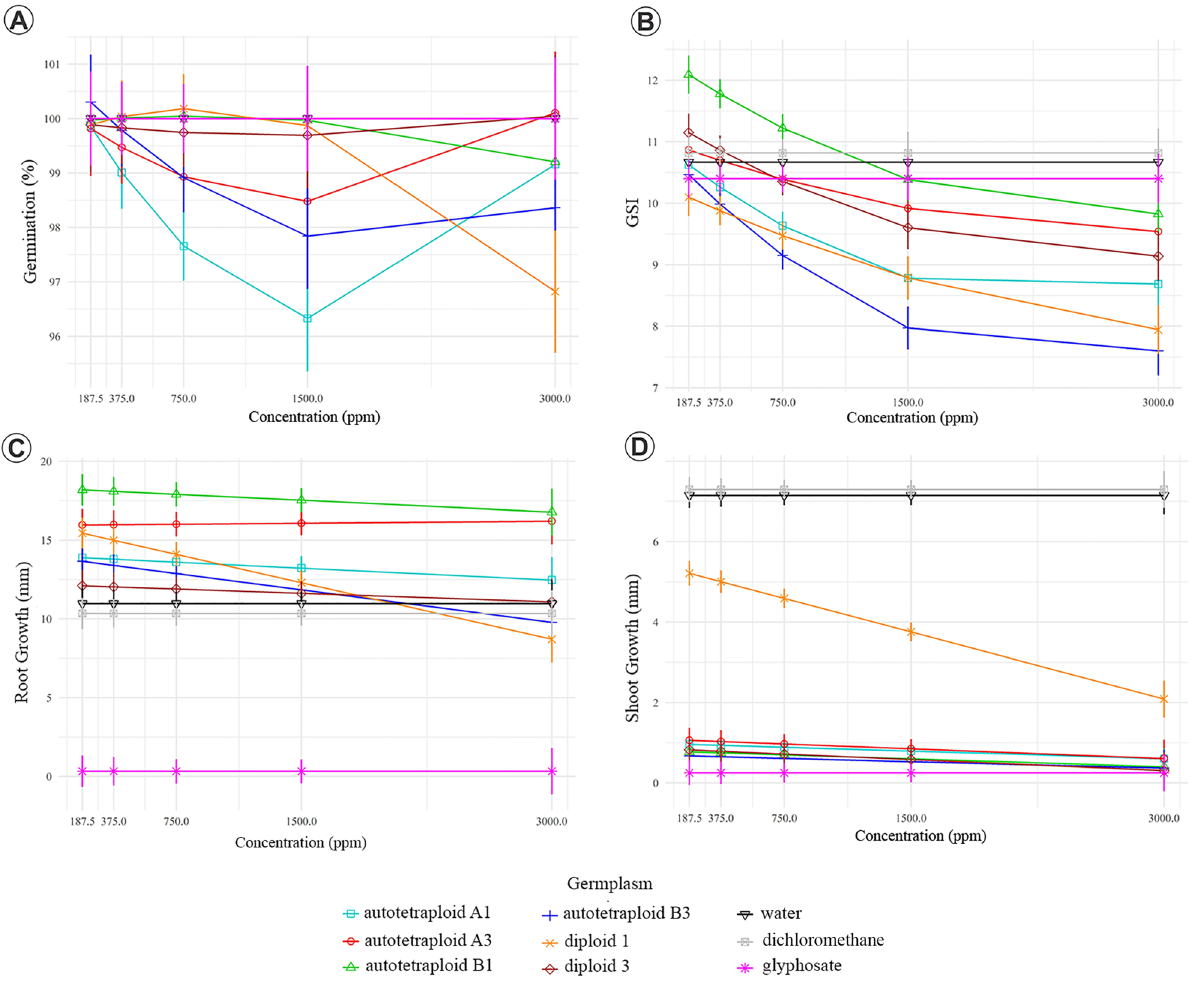
Figure 2. EOs from E. benthamii diploid and autotetraploid germplasms tested in hytotoxicity bioassays. ( a ) GR (%) of L. sativa seeds after 48 h of exposition; ( b ) GSI of L. sativa seeds after 48 h of exposition; ( c ) RG (mm) of L. sativa seeds after 48 h of exposition; ( d ) SG (mm) of L. sativa seeds after 48 h of exposition; Positive control: glyphosate; negative control: water and dichloromethane. Germplasm: diploid 1 and 3 (lower and higher yield); autotetraploid A1 and A3 (lower and higher yield); autotetraploid B1 and B3 (lower and higher yield). The bars are 95% confidence intervals. Overlapped confidence intervals indicates that statistical difference was not